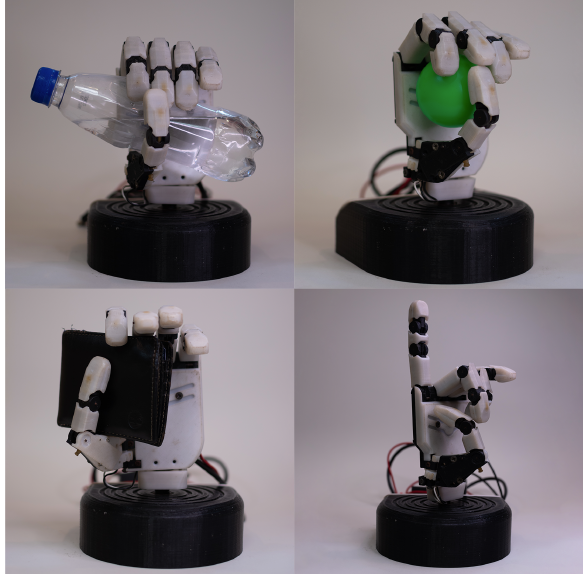
Figure 4. The image shows the Galileo Hand grabbing the objects used in the trials. On the upper left the hand is holding a ”water bottle”; on its right, a small plastic ”ball”; underneath, from left to right, holding a ”wallet” and ”pointing”,